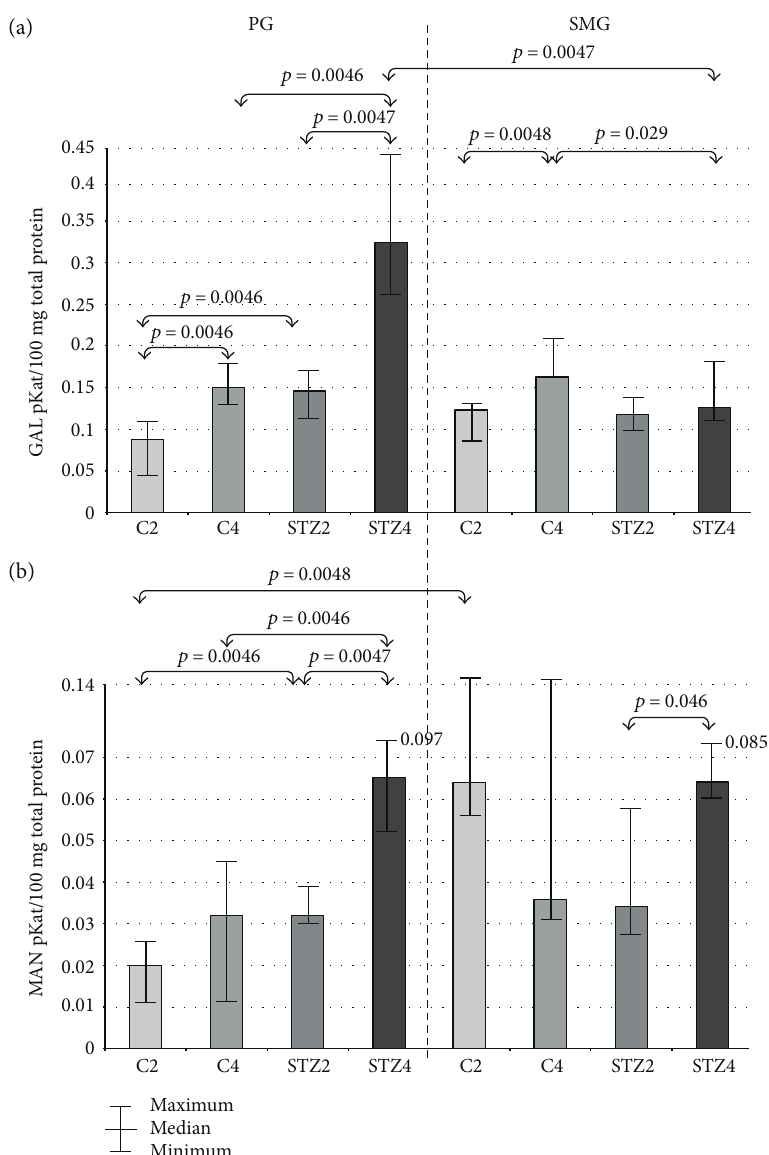
Figure 2: The e ff ect of STZ-induced diabetes on activity of GAL and MAN in the parotid and submandibular glands of rats. C2 and C4 are the control groups. GAL: β -galactosidase; MAN: α -mannosidase; PG: parotid glands; SMG: submandibular glands; STZ2 and STZ4 are the diabetic